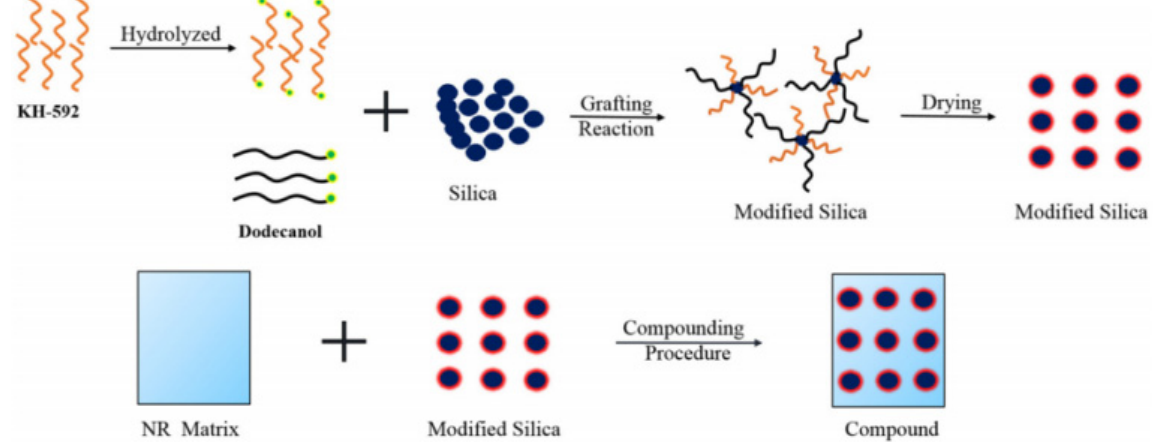
Figure 5. Flowchart for the production of silica/NR for co-modified silica particles with dodecanol and KH-592 [55].